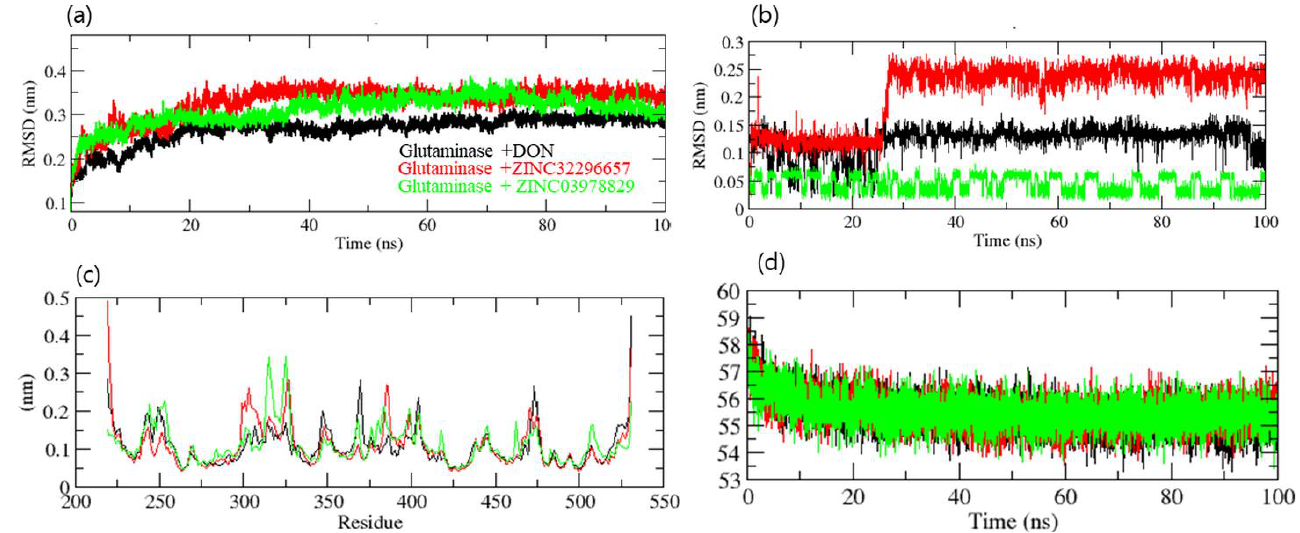
Figure 4. Dynamics study of GLS enzyme. ( a ) RMSD of the backbone of GLS, ( b ) RMSD of com- pounds, ( c ) RMSF, ( d ) volume and density of GLS. pounds, ( c ) RMSF, ( d ) volume and density of